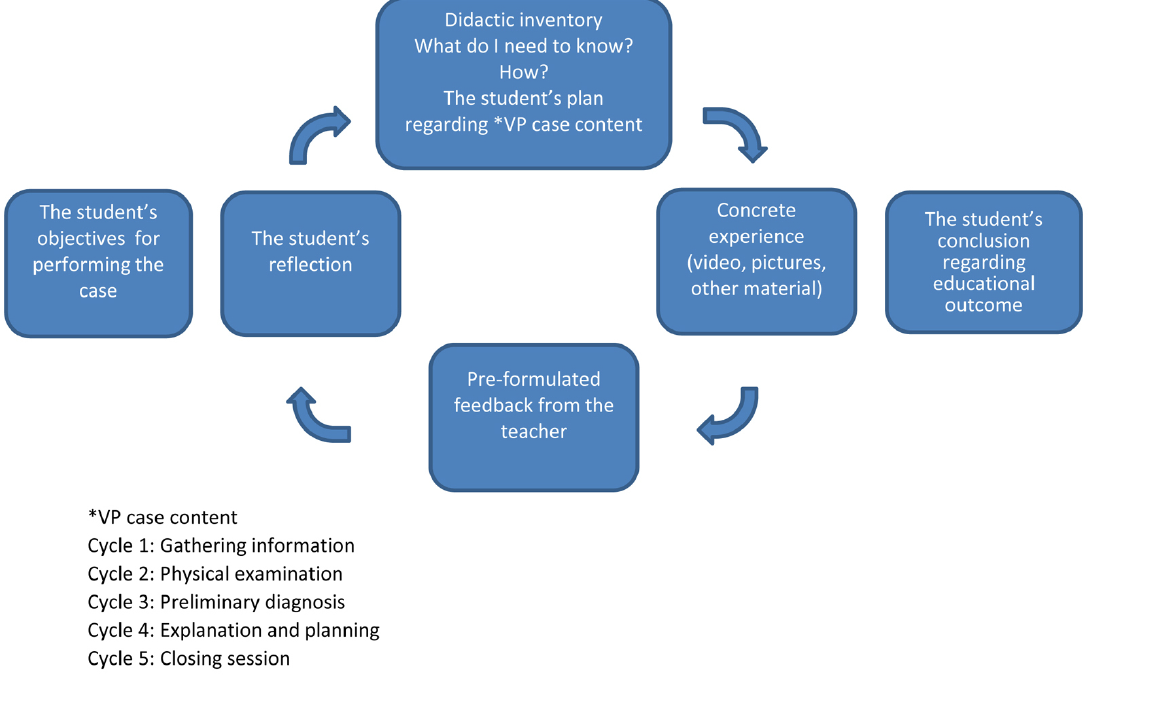
Figure 3. Didactic